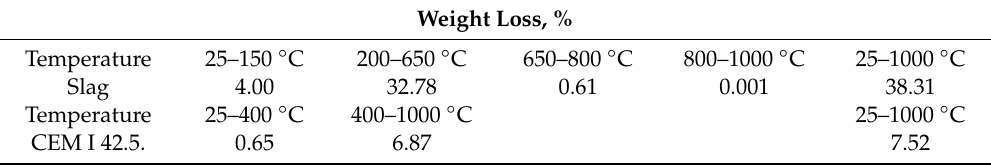
Table 5. Weight loss in di ff erent temperature intervals for slag and CEM I42.5R